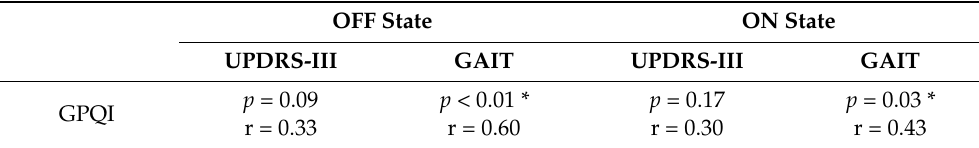
Table 5. p -Values and correlation coefficient of Spearman’s Rho analysis of GPQI for the entire parkinsonian population. Statistical significant differences are starred. OFF State ON State